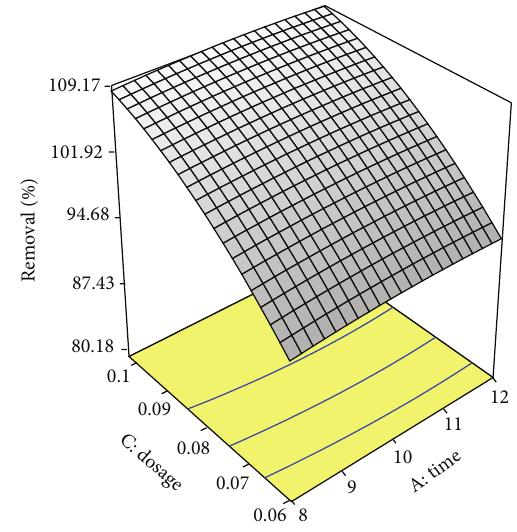
Figure 3: Response surface plot showing the effect of contact time and amount of dosage and their mutual effect on the removal of lead using tartrate-Mg-Al layered double hydroxide.